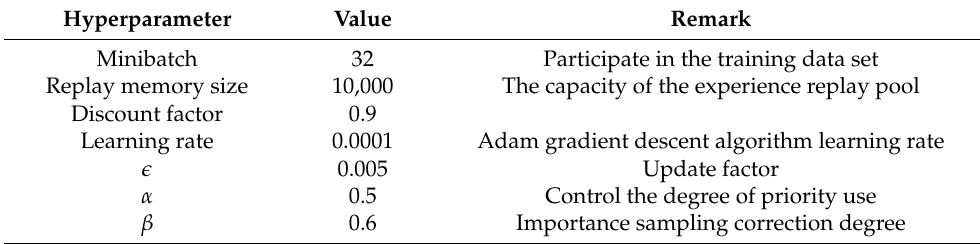
Table 3. Algorithm Hyperparameter Settings In Maze Environment.